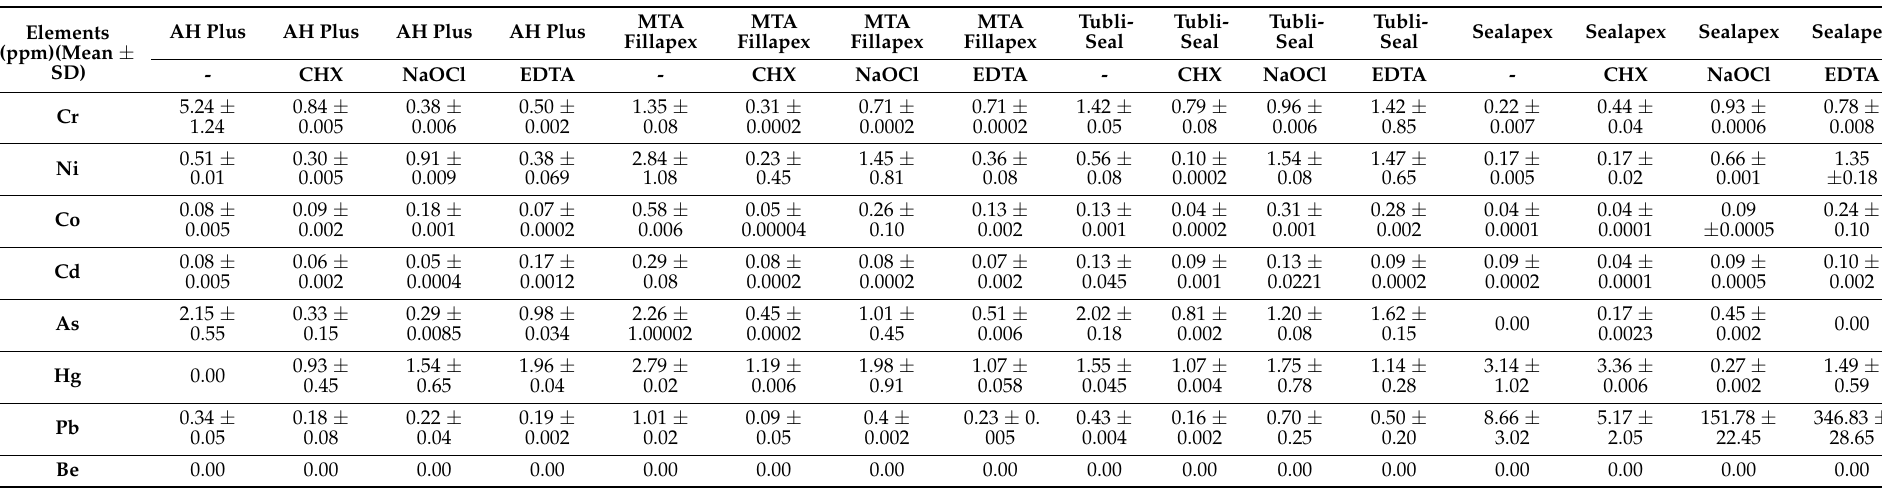
Table 2. Heavy elements present in different base endodontic sealers after assessment with inductively coupled plasma mass spectrometry